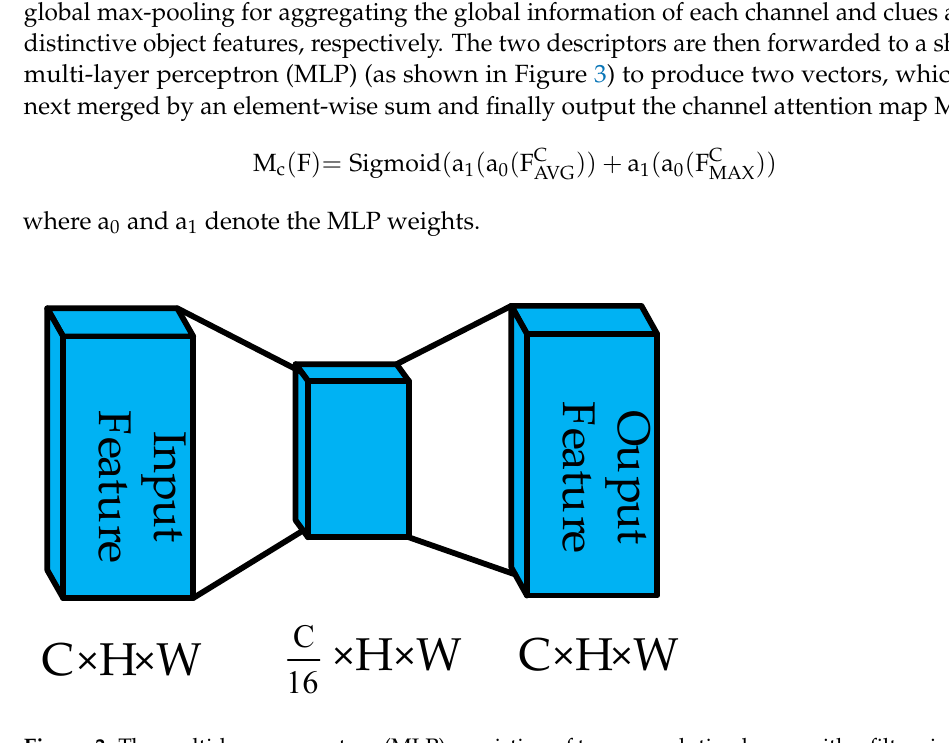
M C Figure 2. The channel attention mechanism. The channel attention explores ‘what’ is useful in an input image by exploiting the inter-channel relationships of features. Firstly, two descriptors including average-pooled